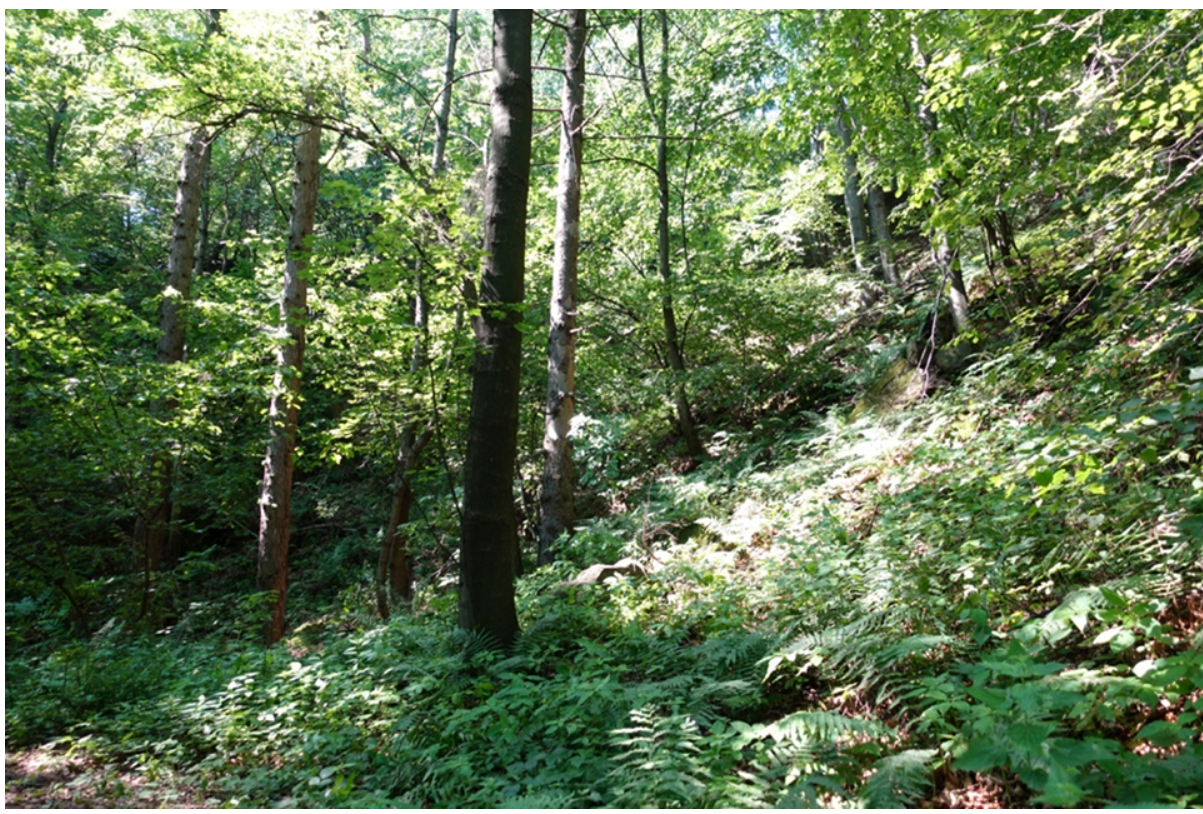
Figure 4 Habitat of Polystichum setiferum at Mt Czupel in the Beskid Śląski (Poland) (photo by D. Tlałka, July 7,